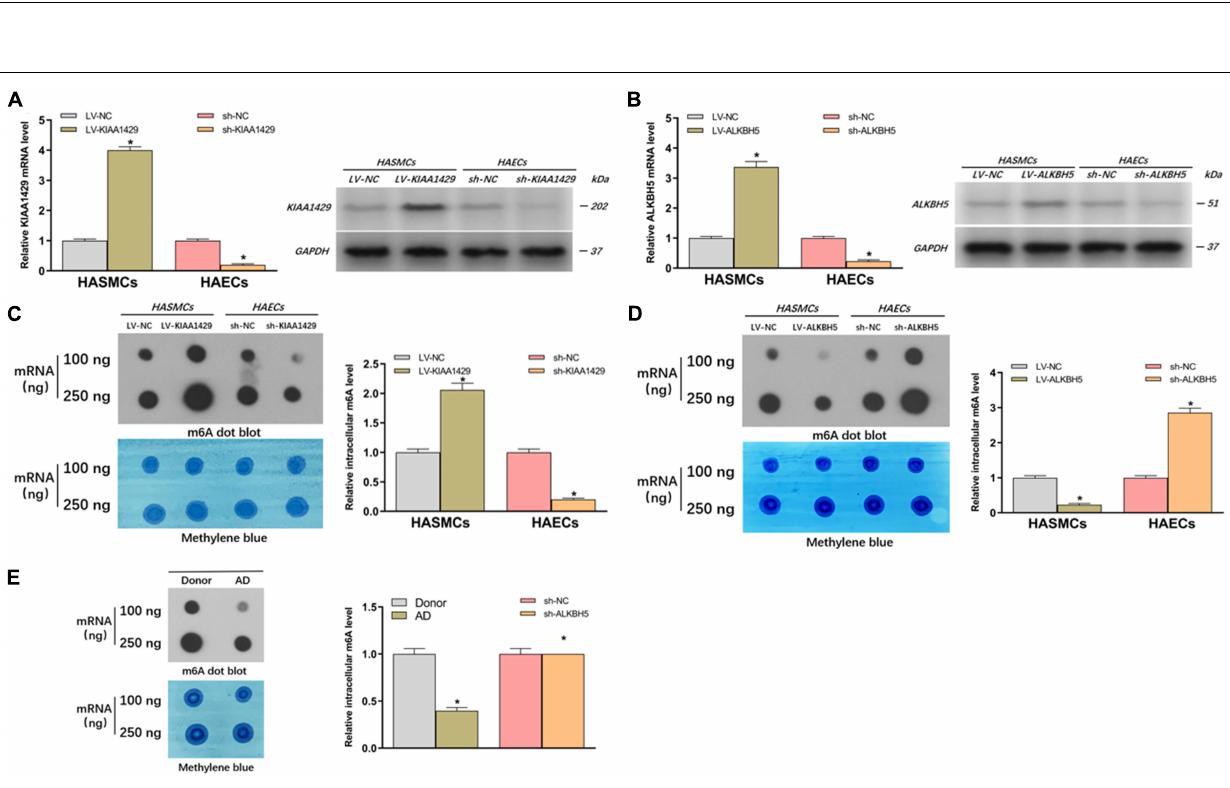
Frontiers in Cell and Developmental Biology |